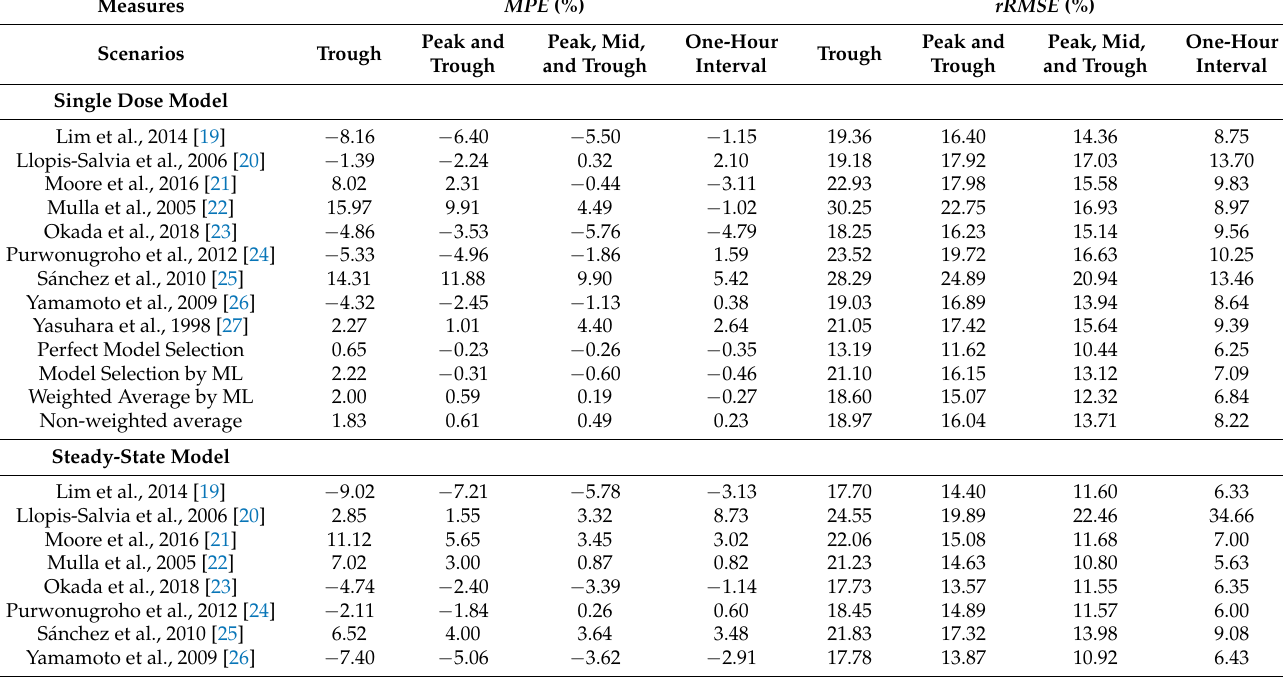
Table 2. The mean percent error ( MPE ) and relative root mean squared error ( rRMSE ) of the predicted AUC relative to the true AUC of each simulation scenario for internal